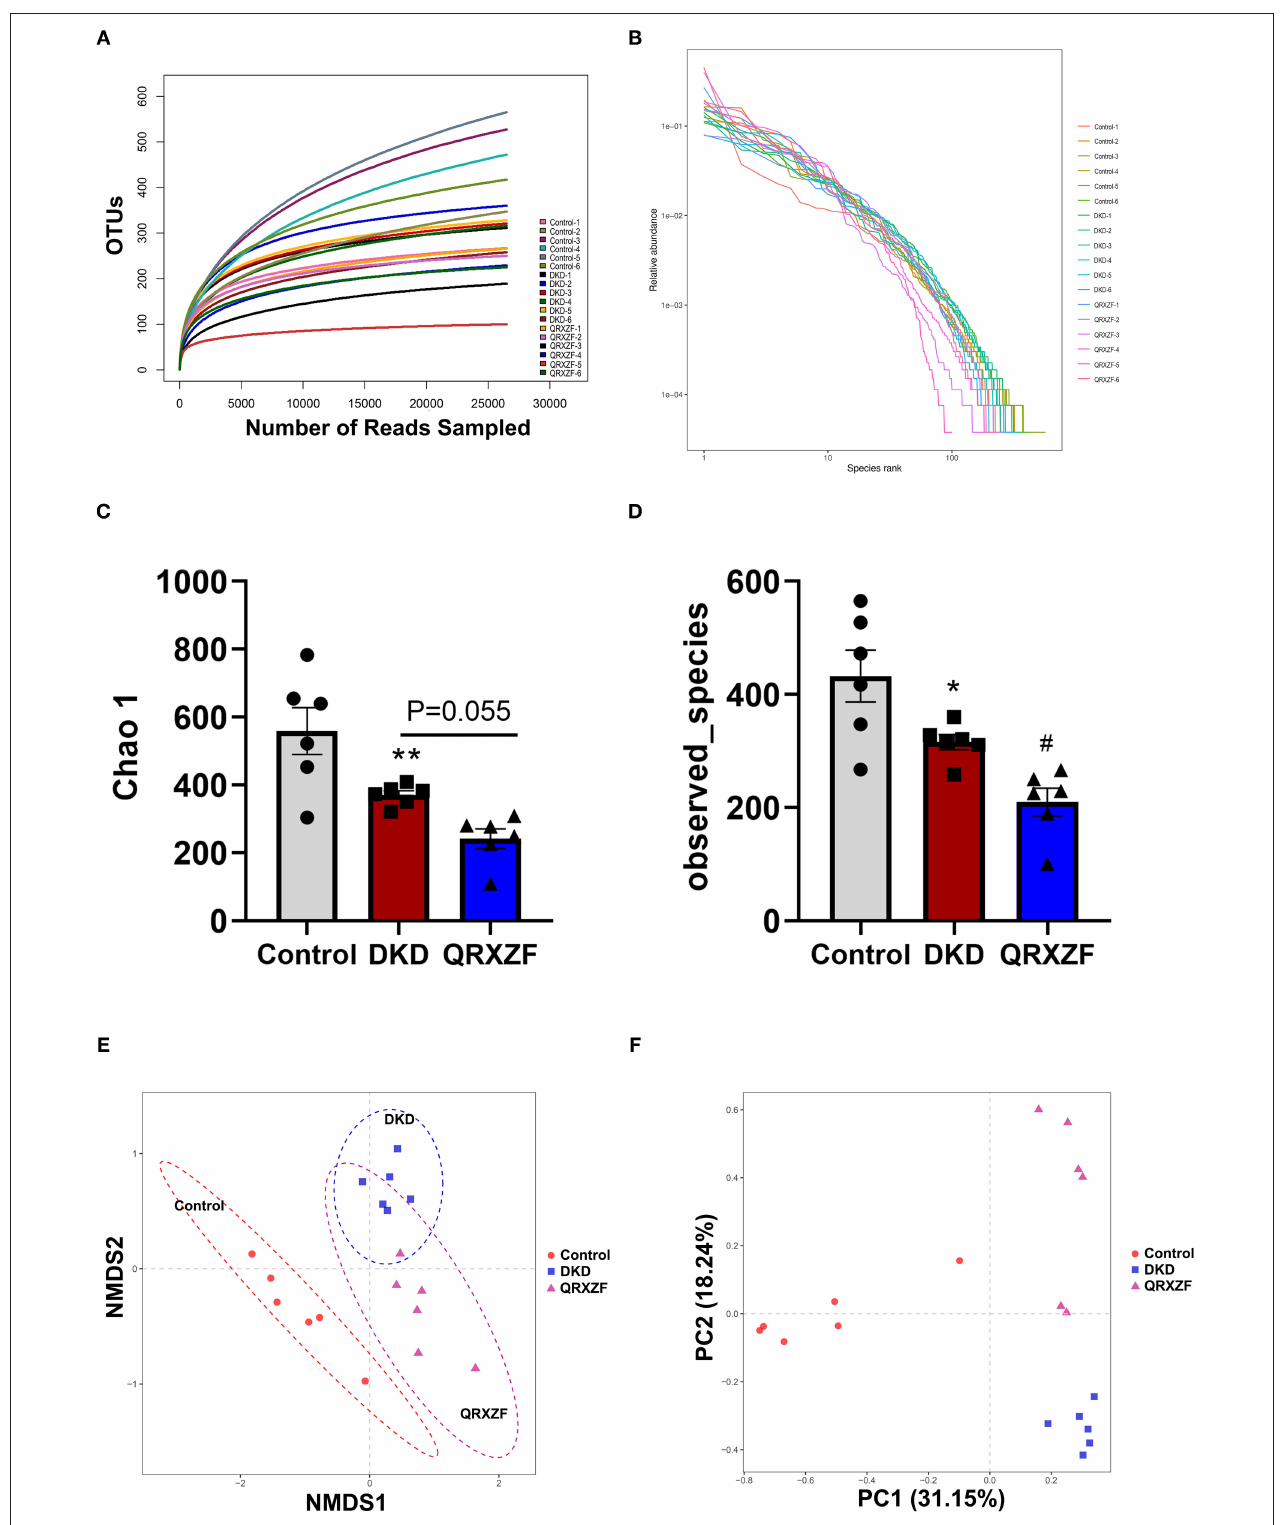
FIGURE 4 | (A) Rarefaction curve; (B) Rank abundance curve; (C,D) Chao1 index and the observed species index ( n = 6, means ± SEM); (E) Non-metric multidimensional scaling (NMDS) analysis between three groups; (F) Principal component analysis (PCA). * P < 0.05, ** P < 0.01, *** P < 0.001 DKD group vs. the control group; # P < 0.05, ## P < 0.01 QRXZF group vs. the DKD